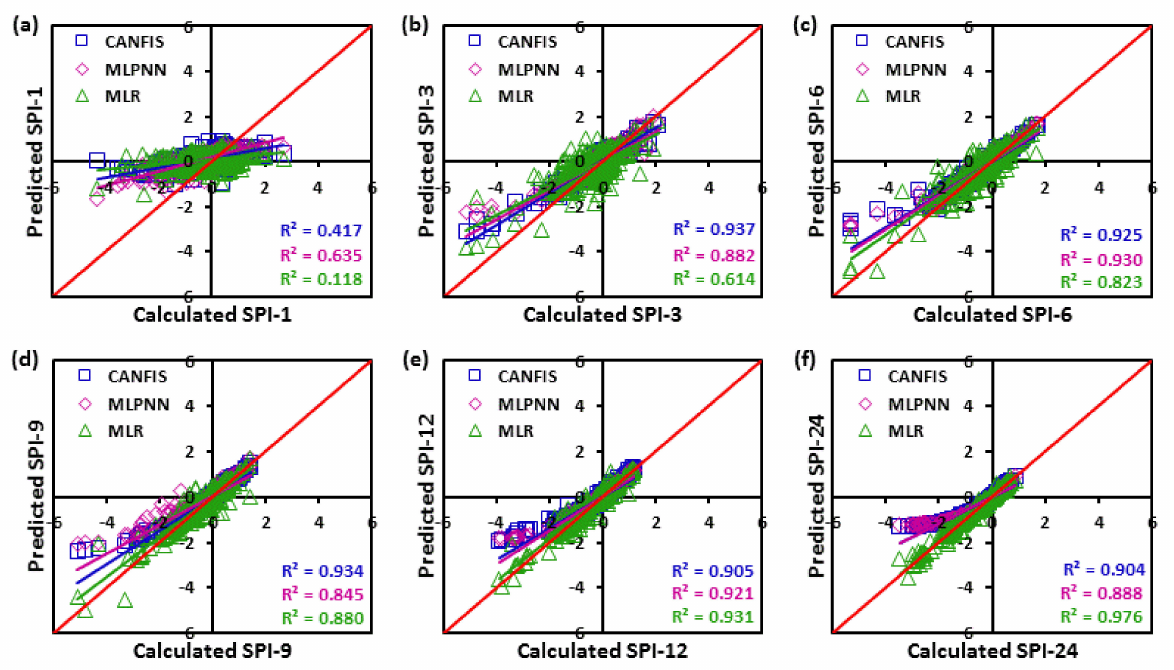
Figure 10. ( a – f ) Scatter plots of calculated and predicted multi-scalar SPI values by CANFIS, MLPNN, and MLR models during the testing period at Uttarkashi